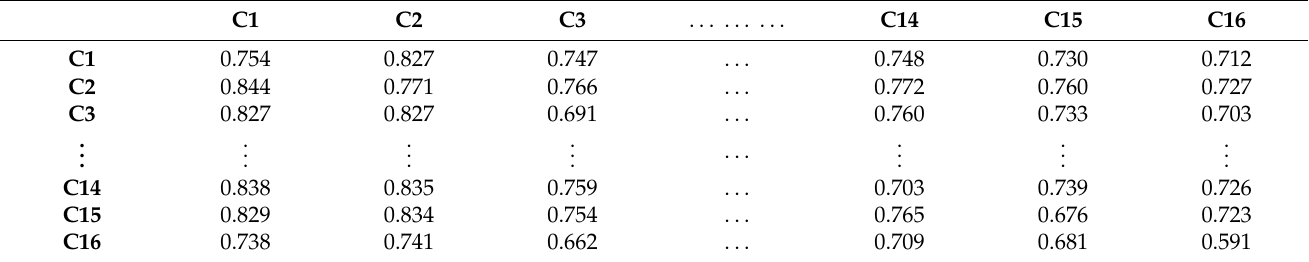
Table 11. Total relationship matrix